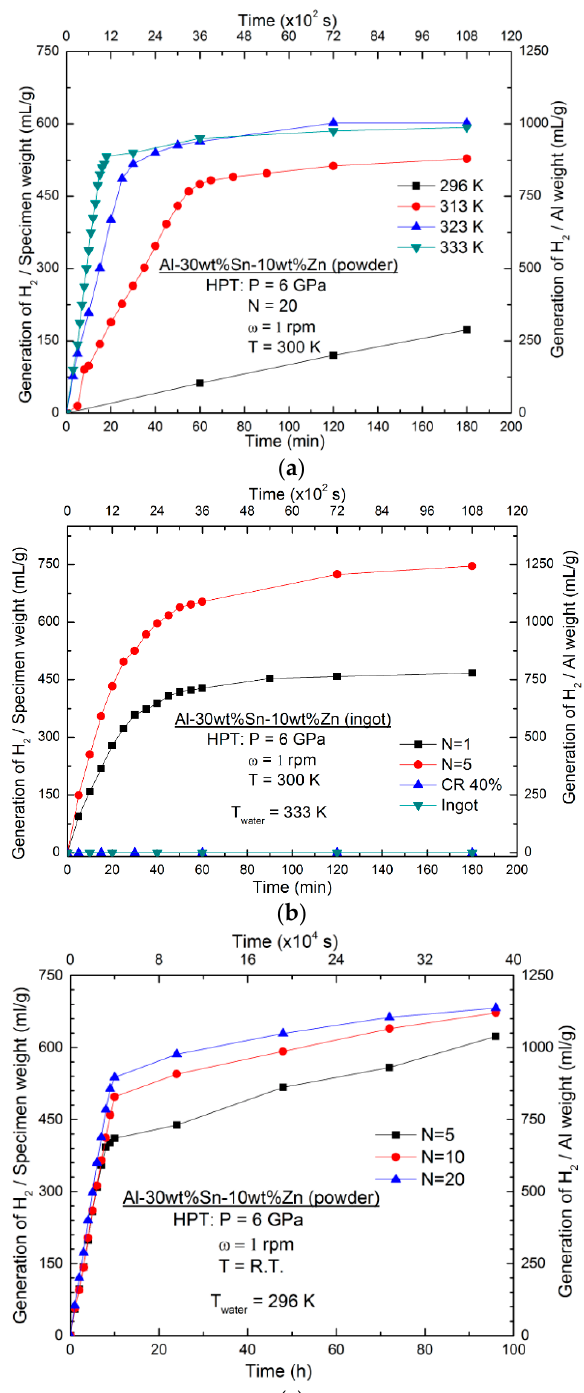
Figure 2. Hydrogen generation against time ( a ) at different temperatures for the Al-30wt % Sn-10wt %Zn alloy processed by HPT for N = 20, ( b ) at 333 K for the Al-30wt % Sn-10wt %Zn ingot processed by rolling and HPT for N = 1 and 5, and ( c ) at 296 K for the Al-30wt % Sn-10wt %Zn powders processed by HPT for N = 5, 10 and 20.